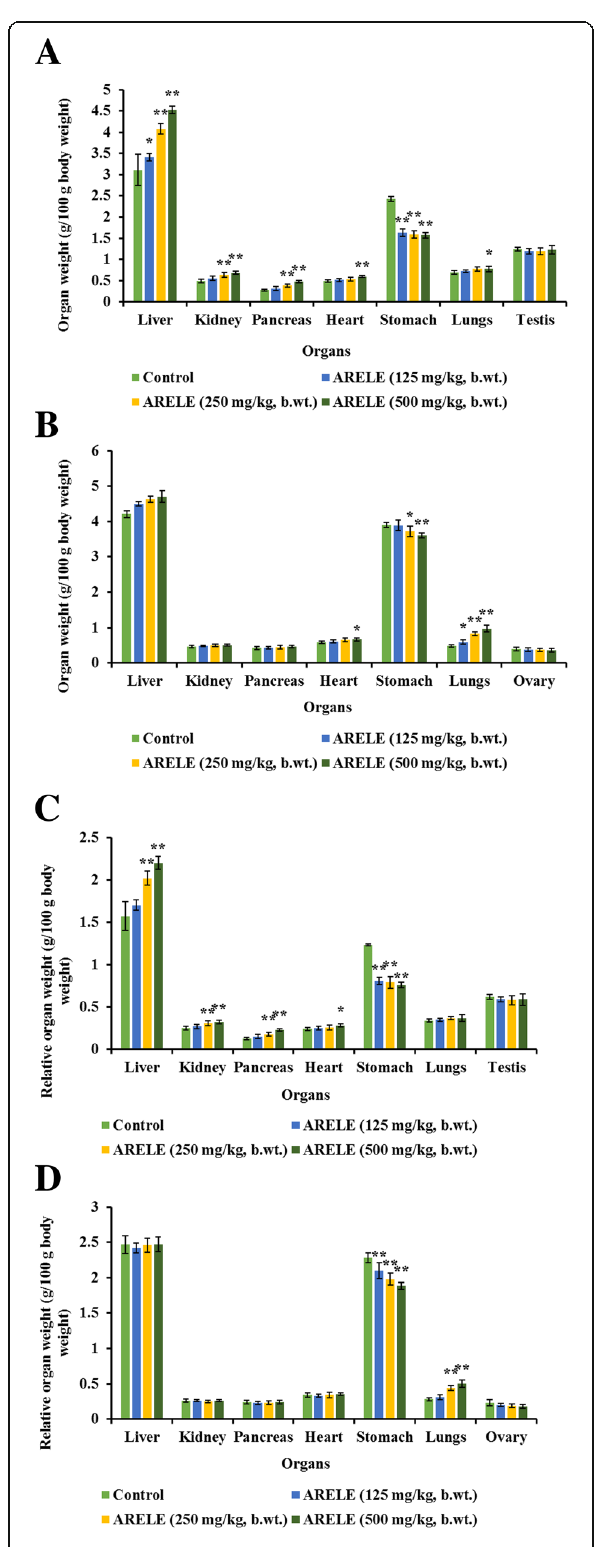
Fig. 2 Effects on organ weight of rats after treatment with ARELE at different doses for a period of 30 days. a Absolute organ weight of male rats. b Absolute organ weight of female rats. c Relative organ weight of male rats. d Relative organ weight of female rats. Values are expressed as mean ± S.D. ( n = 6). Statistical analysis done by one-way ANOVA followed by Dunnet ’ s t-test. ** P < 0.01 compared to control group. * P < 0.05 compared to control